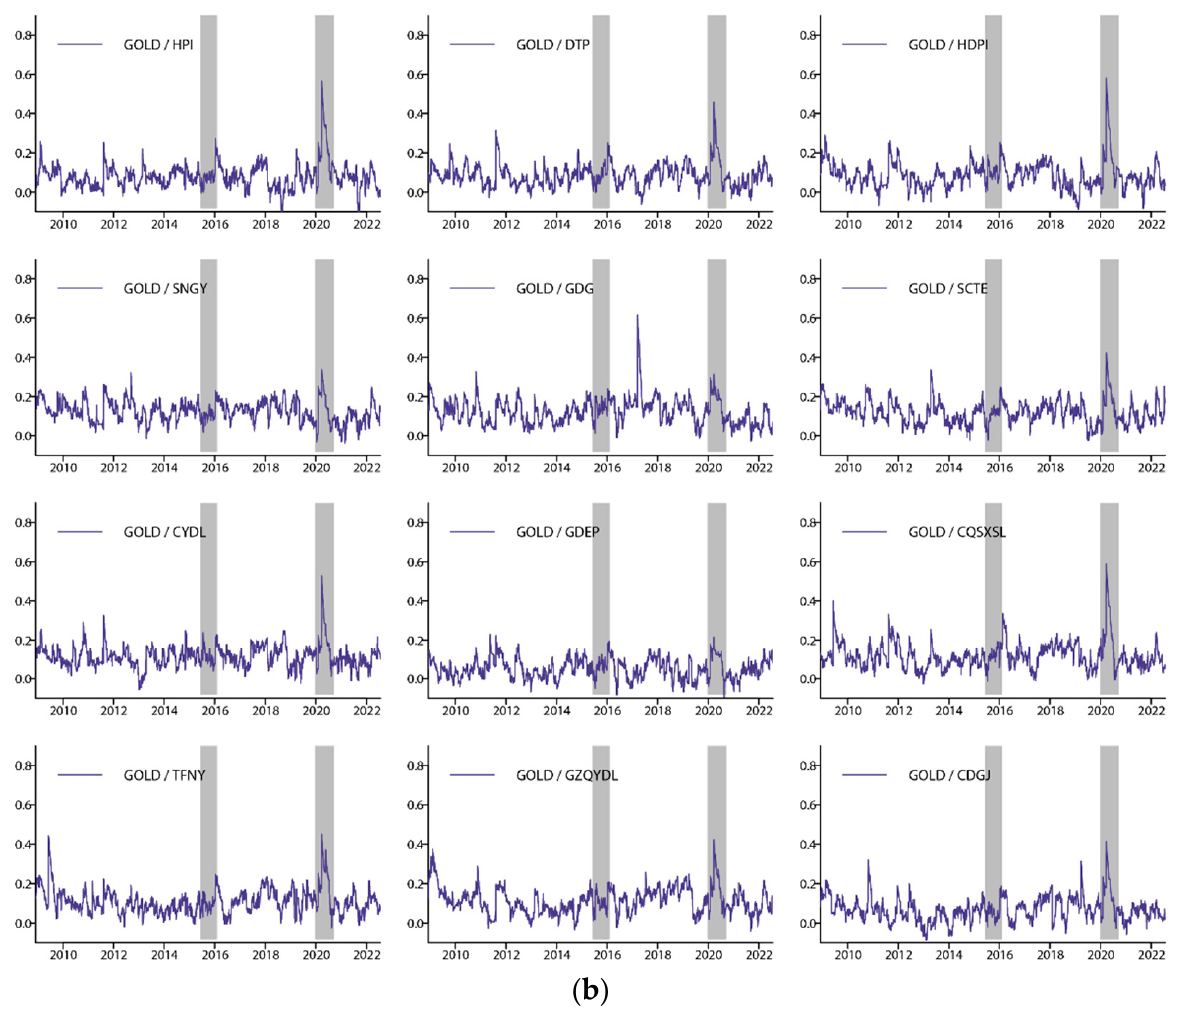
Figure 1. ( a ) Dynamic conditional correlation between WTI volatility and electricity companies’ stock price volatility; ( b ) Dynamic conditional correlation between gold volatility and electricity companies’ stock price volatility. Note: The first and second shaded bars refer to two crisis periods, namely, the stock market crash period and the COVID-19 epidemic period.